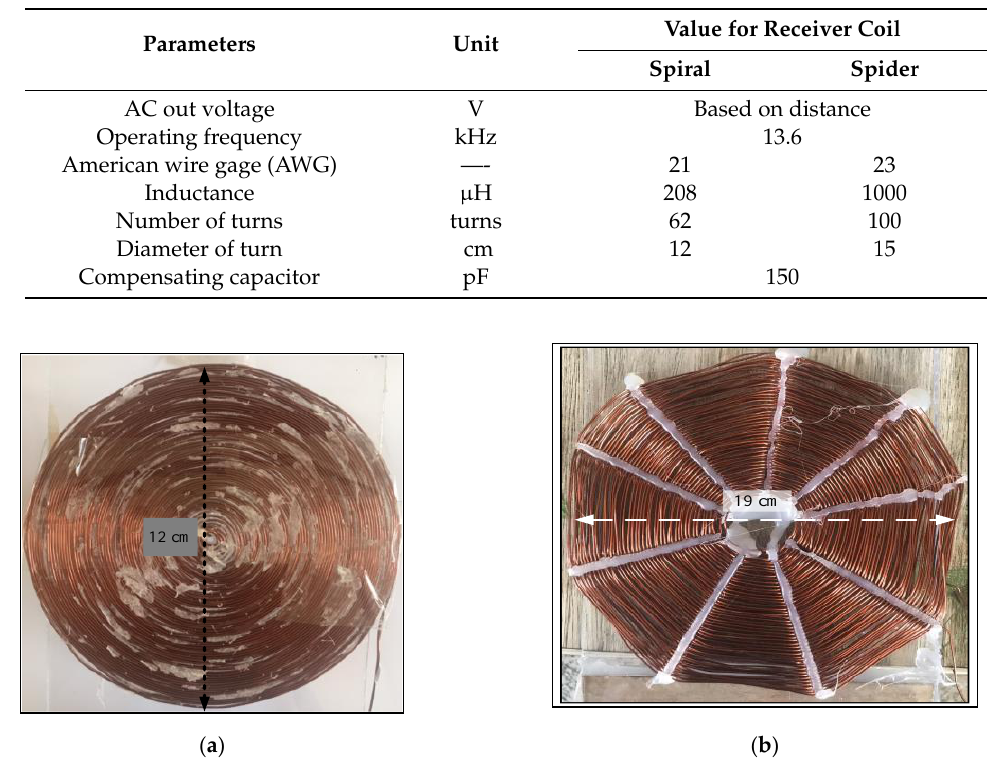
Table 2. Specification for receiver coils.